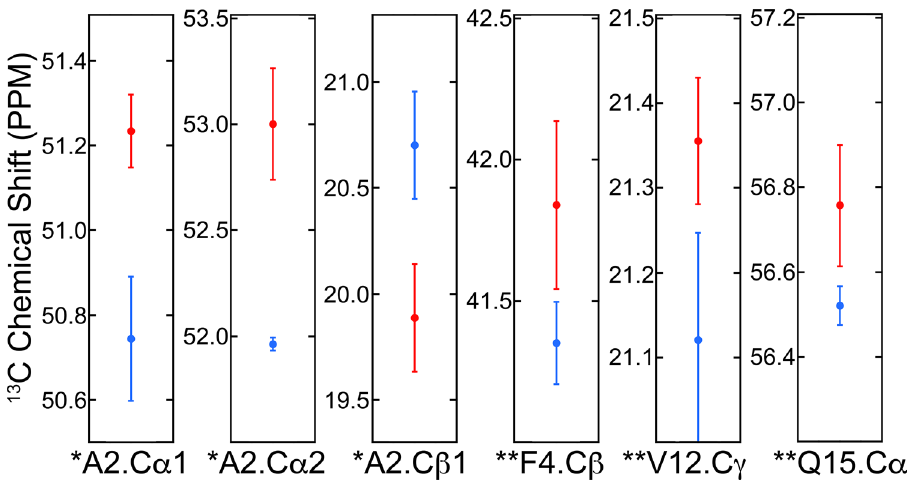
Figure 6. Analysis of chemical shifts of brain parenchyma- vs, vascular-seeded Aβ40 fibrils. A) Mean values for chemical shifts for three brain parenchyma-seeded (red) or vascular-seeded (blue) samples, using tissue from Patients 1, 2, and 3. Points represent means of these values, with standard deviations. For three of the peaks (*), parenchyma- and meninges-seeded samples were different by t-test to p < .01; for the other three peaks (**), parenchyma- and vascular-seeded samples were different by t-test to p < .05.